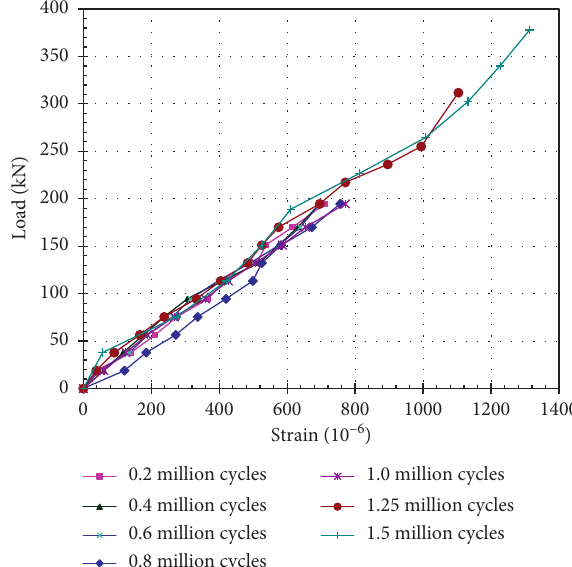
Figure 27: PLG-2 reinforcement strain comparison of midspan concrete slab.